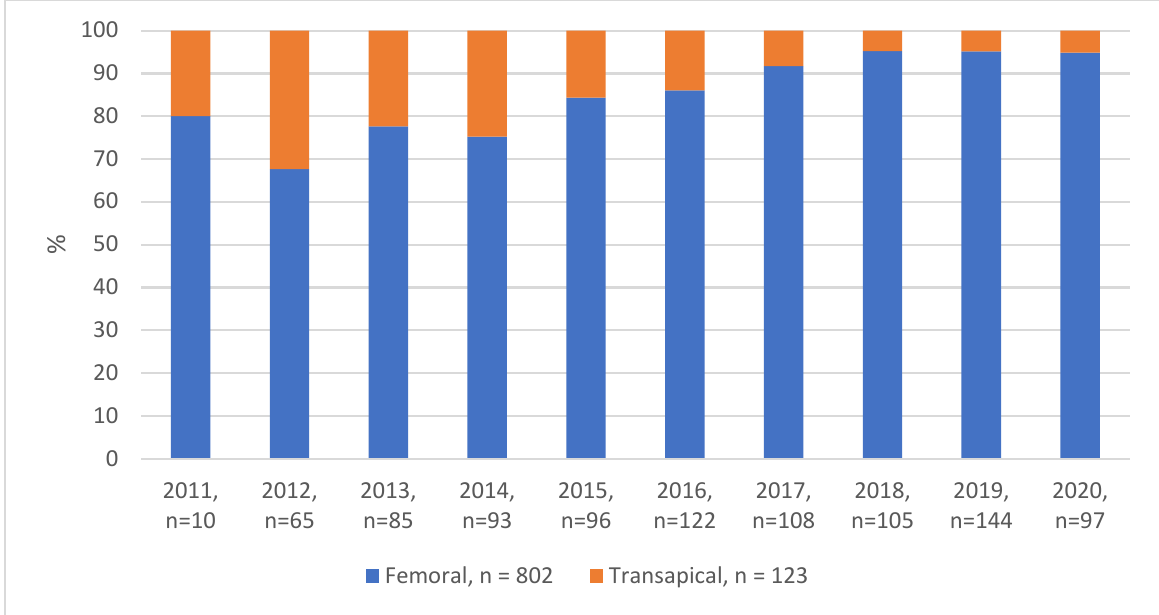
Figure 2. Percentage distribution of transfemoral and transapical TAVI per year: Shown is the percentage distribution for both procedures in each year. At the beginning of 2015, there is a trend in favor of using transfemoral access and a decrease of using transapical access for TAVI each year. Since 2018, around 5% of patients per year undergo transapical approach.